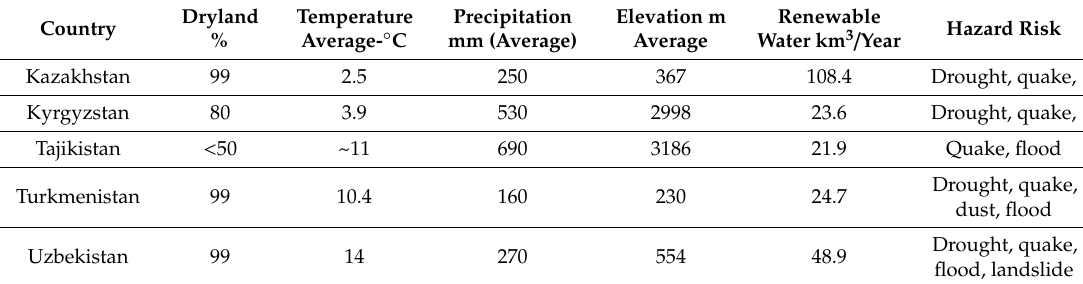
Table 2. Physical characteristics of Central Asian states